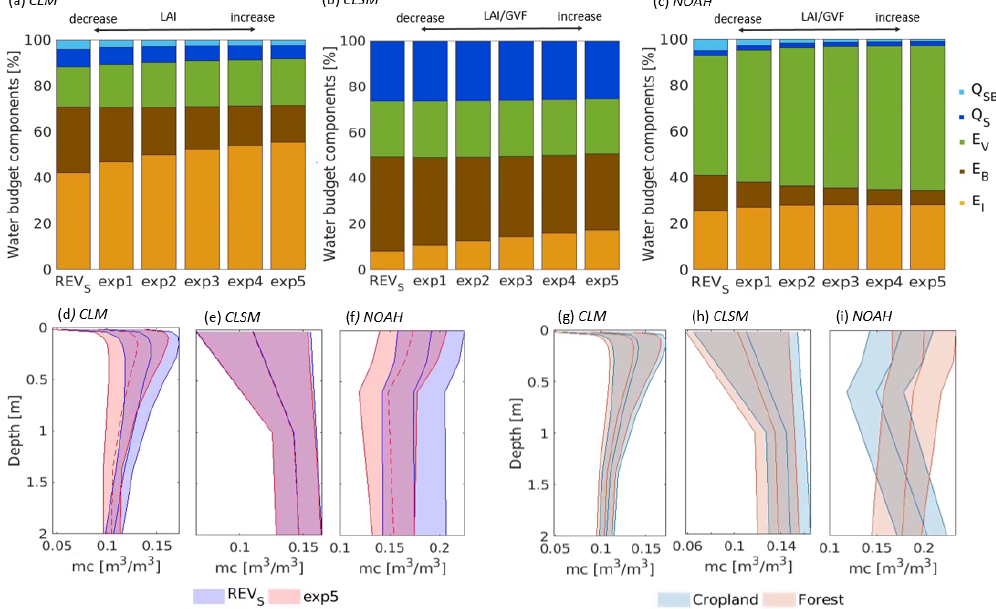
Figure 7. (a–c) Long-term (1992–2015) water budget components averaged over the Dry Chaco for SENS V experiments, for CLM, CLSM and NOAH, respectively. Exp1 to exp5 refer to simulations whereby the monthly climatological LAI maps were increased by, respectively, 1 to 5 units ( Q SB : subsurface runoff, Q S : surface runoff, E V : vegetation transpiration, E B : bare soil evaporation, E I : interception evapora- tion). (d–f) Associated impact on the soil moisture profile (spatially averaged profile) for CLM, CLSM and NOAH, respectively. (g–i) Impact of changing land cover parameters (SENS LC ) from deciduous forest to cropland on the soil moisture profile for CLM, CLSM and NOAH,